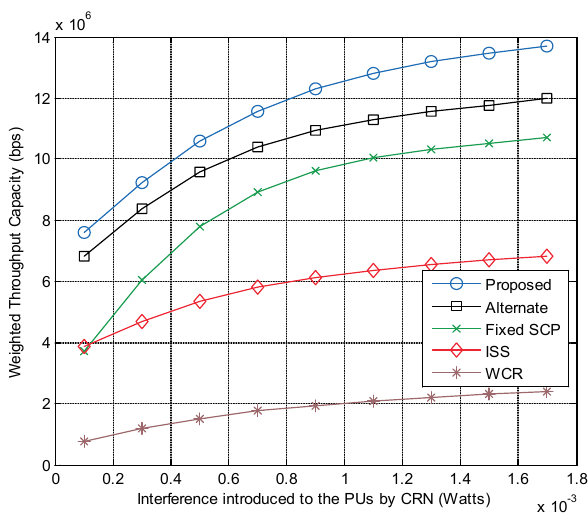
Figure 5. Weighted throughput capacity of the CRN versus interference introduced to the PUs by several schemes.